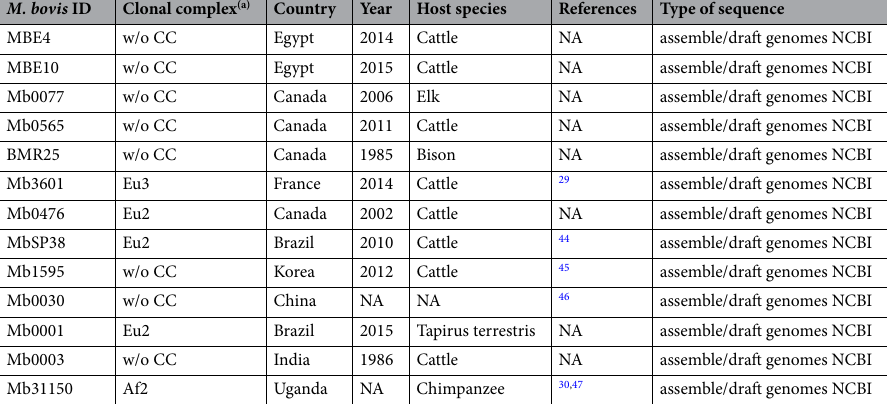
Table 1. Characteristics of Mycobacterium bovis genomes used in this work. Eu1: European 1, Eu2: European 2, Eu3: European 3, Af1: African 1, Af2: African 2, and w/o CC: without clonal complex. NA: non-available information.